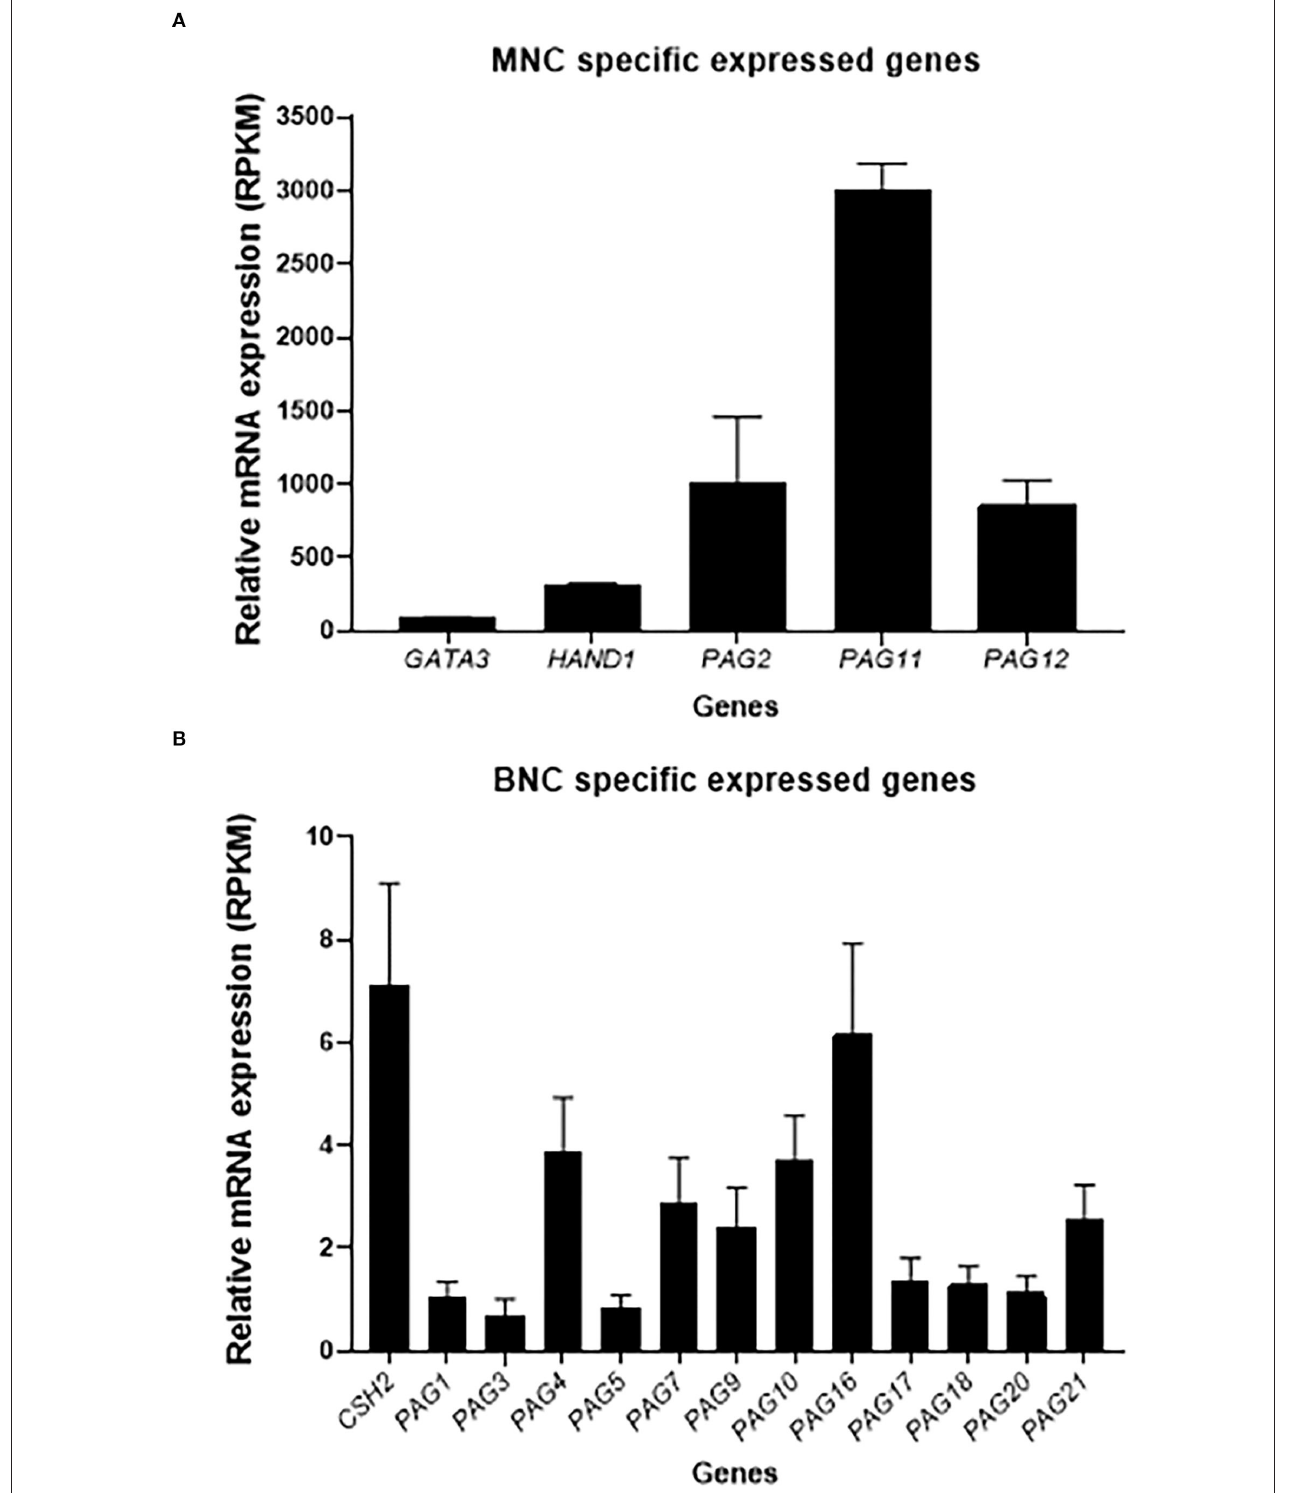
FIGURE 6 | Gene expression of TE marker genes through transcriptome analysis. A total of eight outgrowths at day 35 and 41 were analyzed. (A) MNC specific genes expressed TE outgrowths. (B) BNC specific genes expressed in the TE outgrowths. Values are presented as RPKM ± SEM.